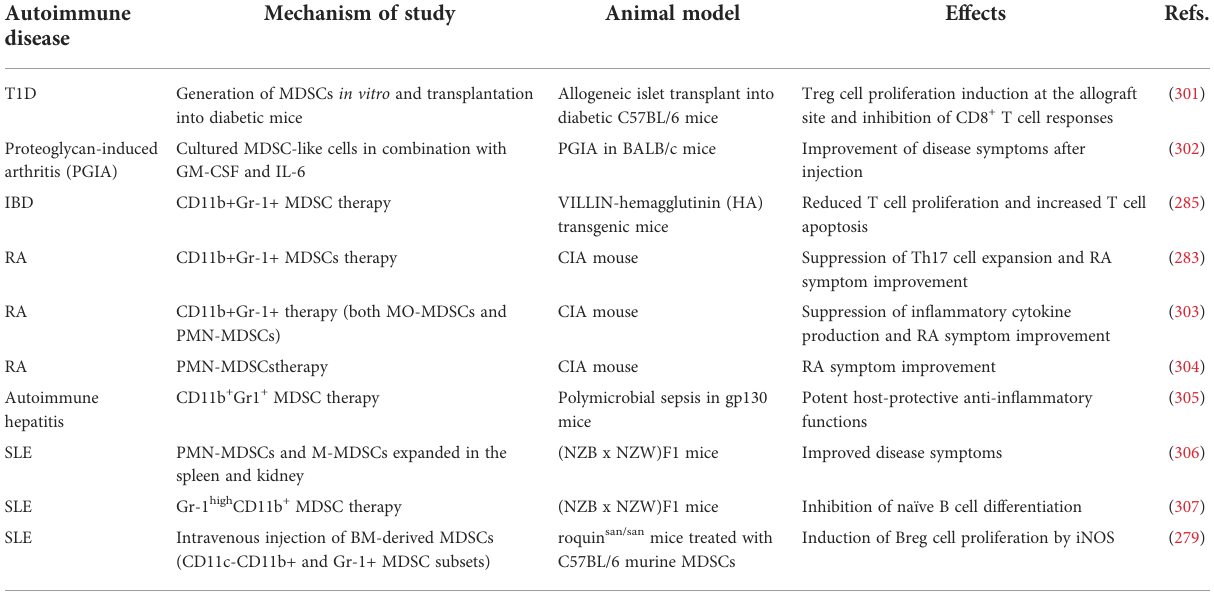
TABLE 4 Preclinical studies on MDSCs in autoimmune